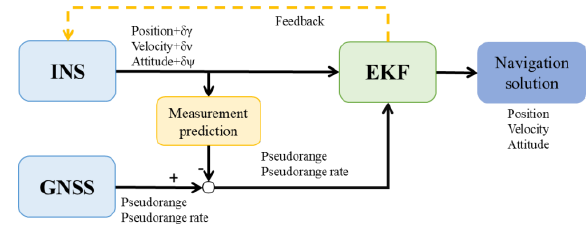
Figure 3. Structure of TC